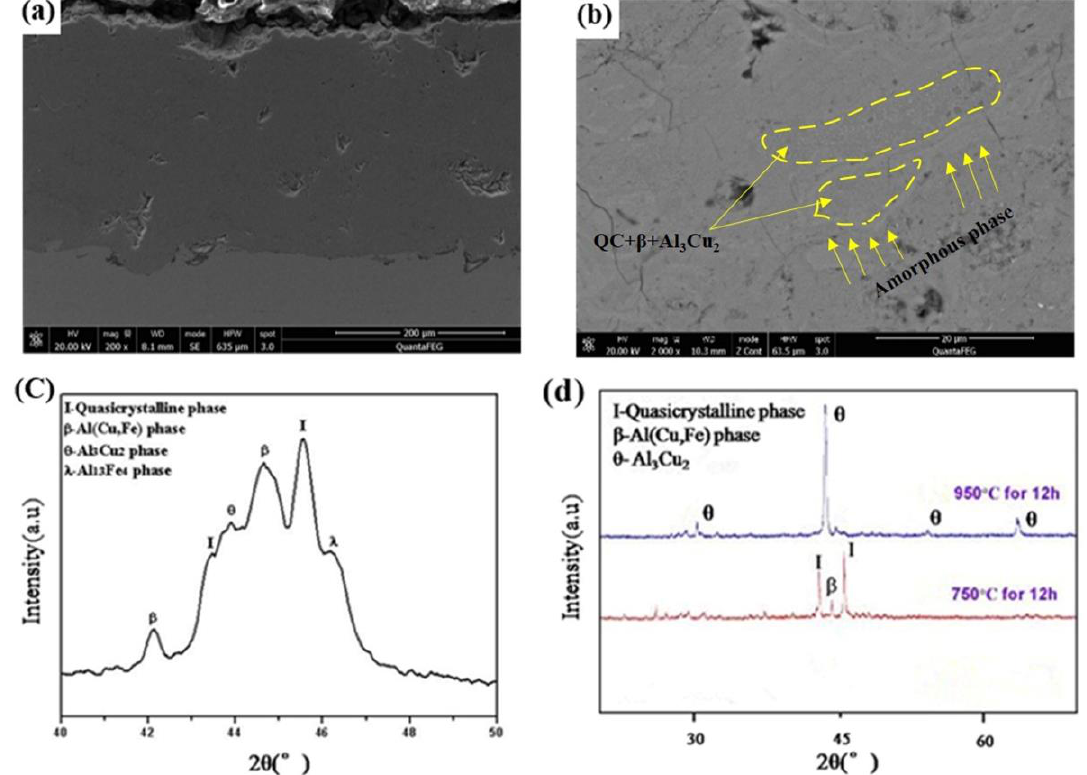
Figure 5. XRD pattern and SEM image of the high velocity air fuel (HVAF)-sprayed Al 50 Cu 20 Fe 15 Si 15 coating. ( a ) Cross section SEM image in SE mode; ( b ) diagram of flattened particle in BSE mode; ( c ) XRD pattern of spraying coating; ( d ) XRD pattern of the coating annealed at 750 ℃ /12 h and 950 ℃ /12 h.